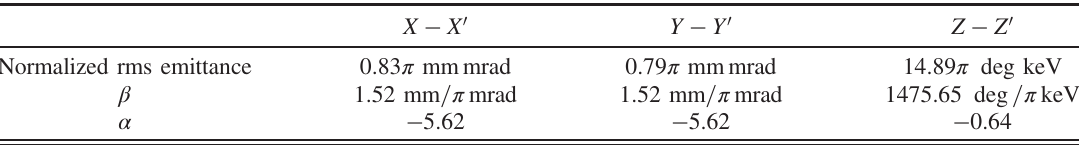
TABLE I. Beam parameters of the used empirical beam distribution for the RFQ beam matching